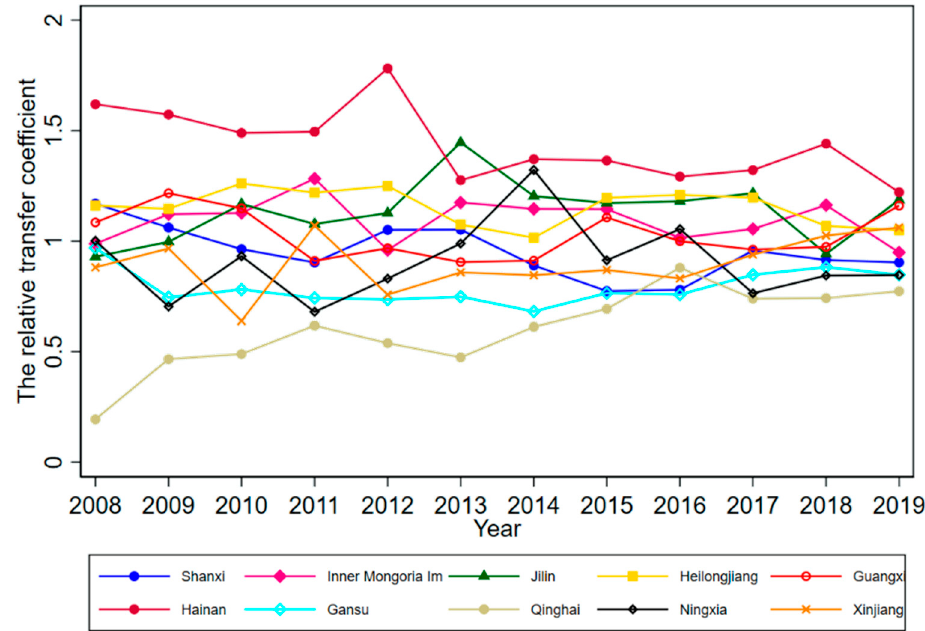
Figure 7. Relative transfer paths of HQDM levels in Club 4 member provinces.